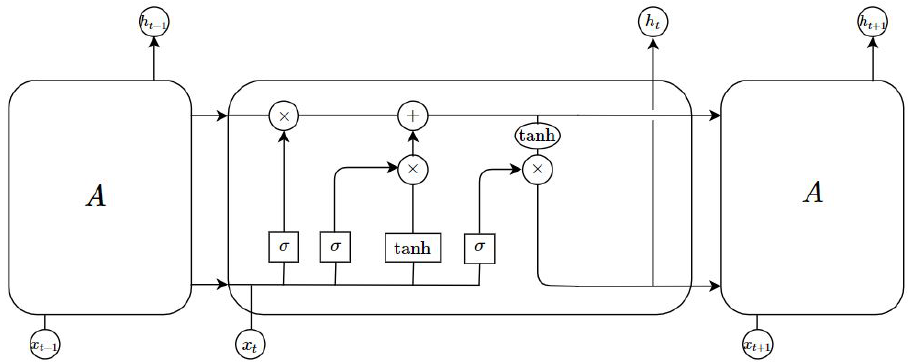
Figure 2. Repeating module in a long short-term memory (LSTM)